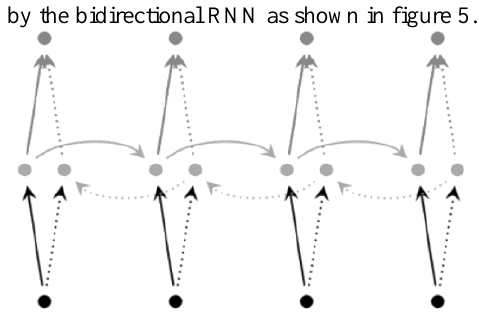
Figure 5. Structure of bidirectional RNN